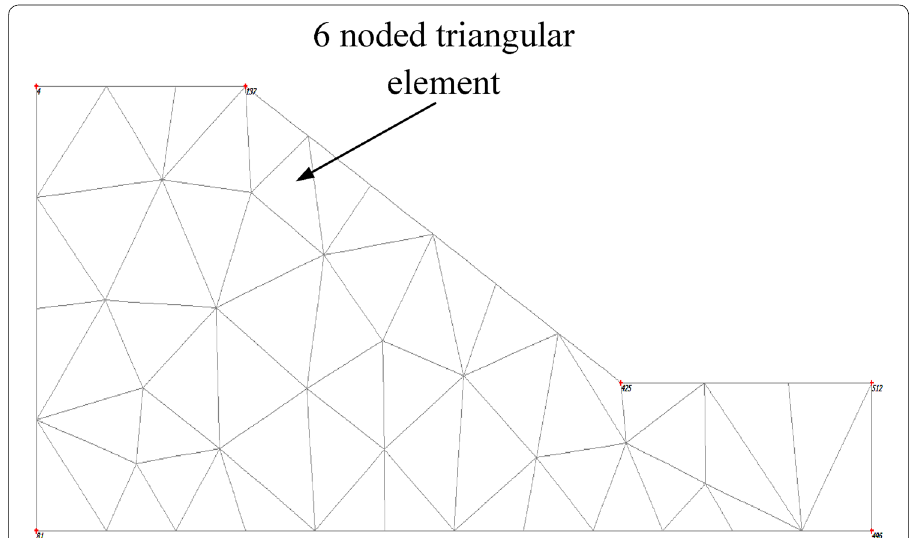
Fig. 11 Plot of mesh with significant nodes before analysis ( β 20°) = Table 5 Input soil parameters for PLAXIS Soil parameters Values Units Modulus of Elasticity ( E ) 15,000 kN/m 2 Poisson’s Ratio ( ν ) 0.17 – Cohesion ( c ) 10 kN/m 2 Angle of internal Friction ( φ )